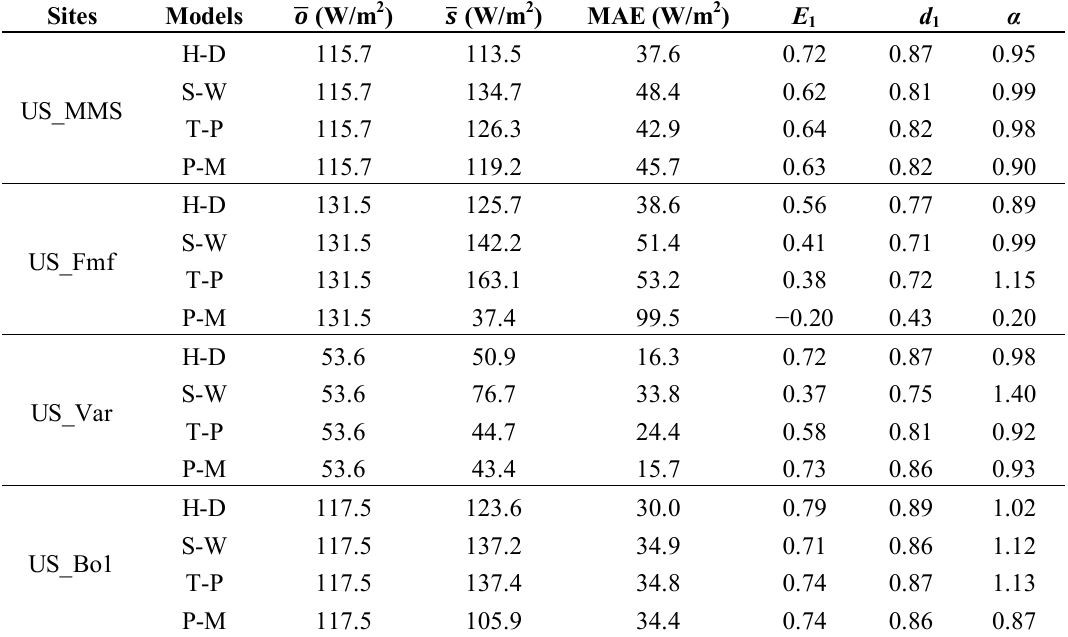
Table 2. Statistic summary of the four models in estimating actual evapotranspiration over 30-min period at four sites. (cid:2201)(cid:3364) is the mean estimated value.